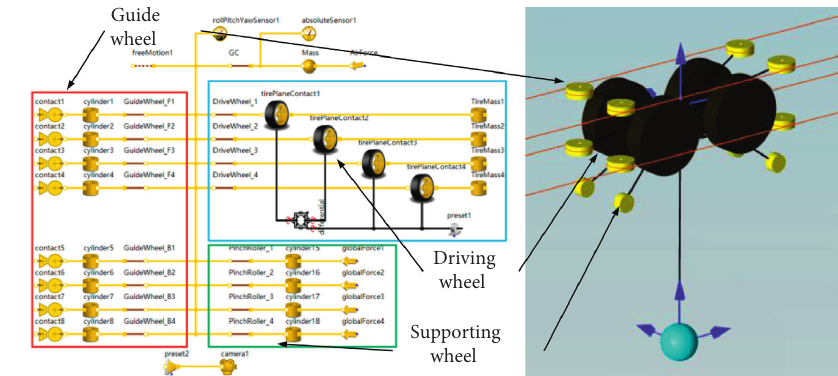
Figure 3: Dynamic model of the vehicle.